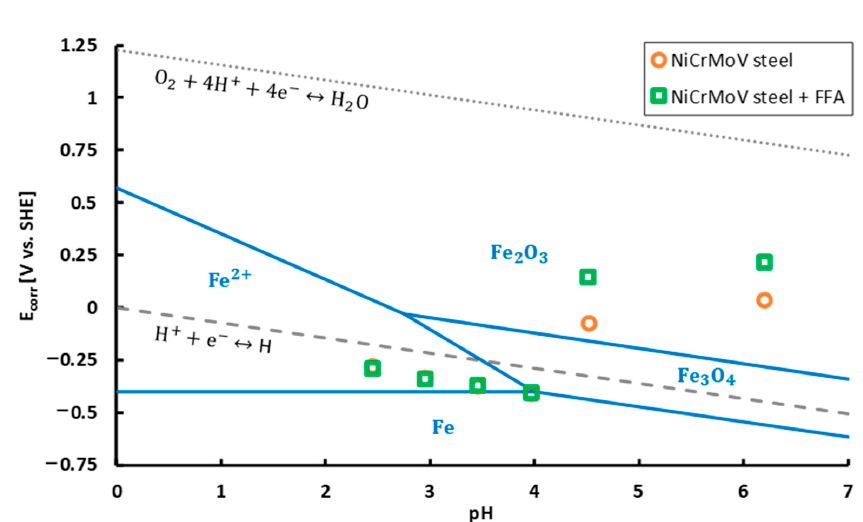
Figure 14. Influence of FFA coating on corrosion potential (E corr ) of NiCrMoV steam turbine steel at 90 °C. Dotted line represents the oxygen reduction reaction line, dashed line represents the hydrogen proton reduction reaction line. Thermodynamically stable forms of iron (molality of 1) are represented in blue. Diagram based on thermodynamic data from FactSage©.